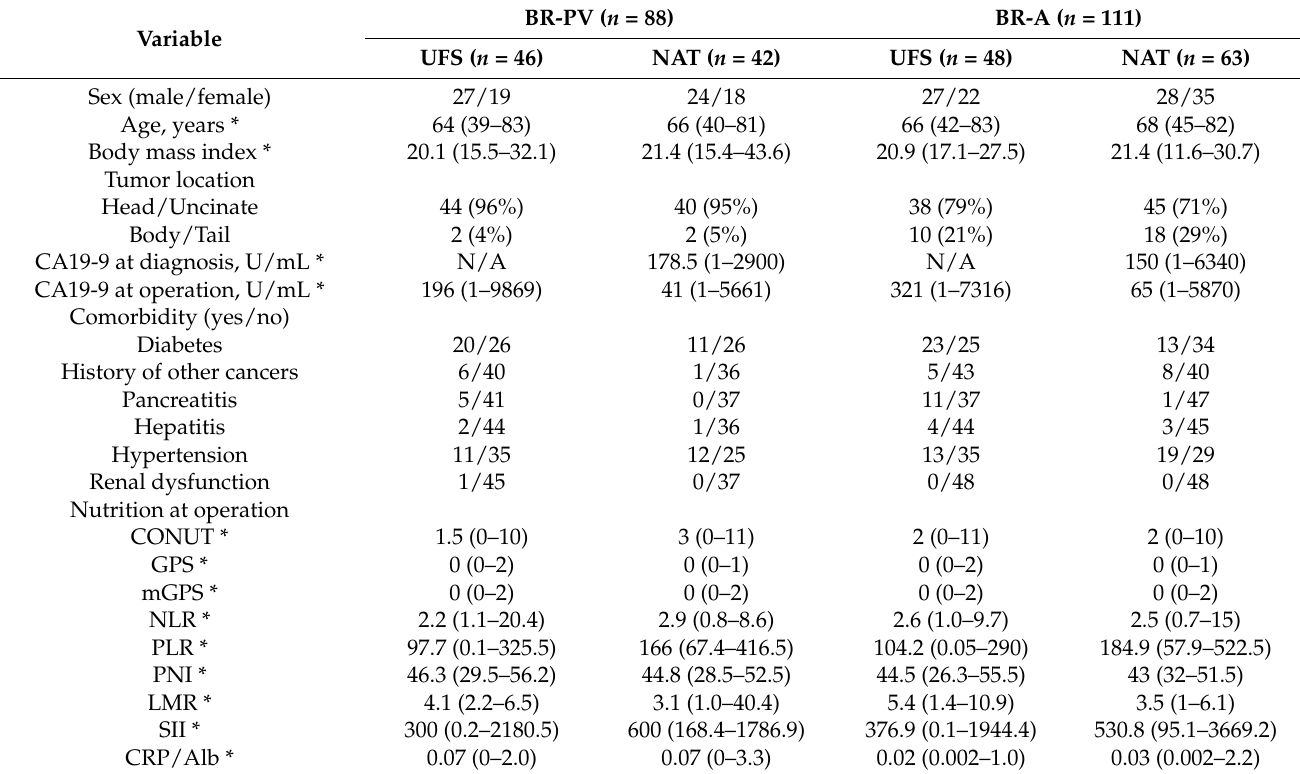
Table 3. Baseline characteristics of patients with BR-PDAC who underwent upfront surgery or